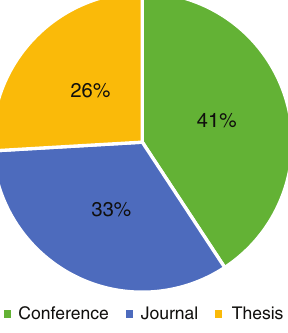
Figure 3. Type of